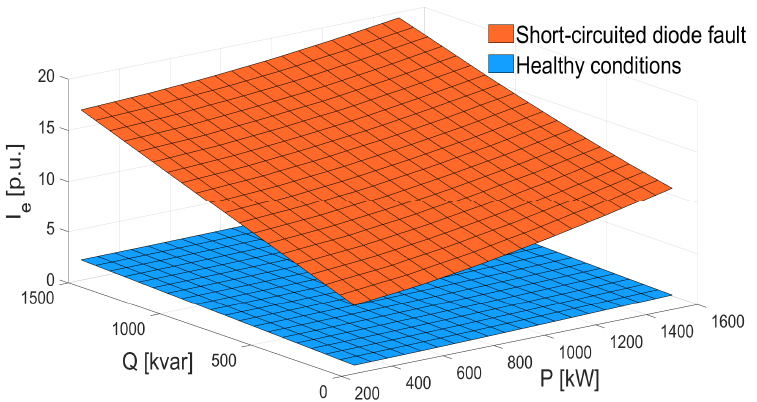
Figure 6. Simulation results. I e (p.u.) represented for different (P, Q) operating setpoints at reference voltage for F2: shorted-diode fault.